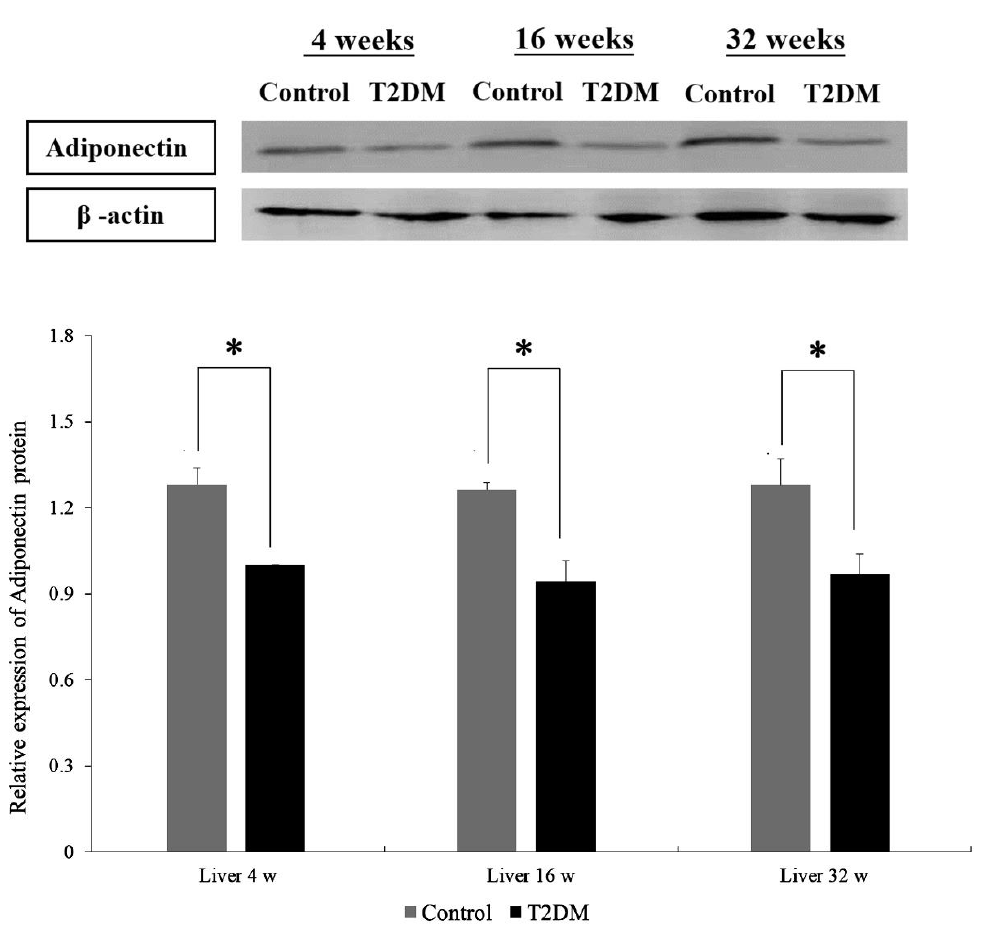
Figure 1. Western blot analyses of protein expression levels of Adiponectin (ADP) in the liver tissue of Control and T2DM mice at 4, 16, and 32 weeks, respectively. Data are expressed as mean ± standard error of 3 independent experiments. * p < 0.05 for the comparisons indicated.